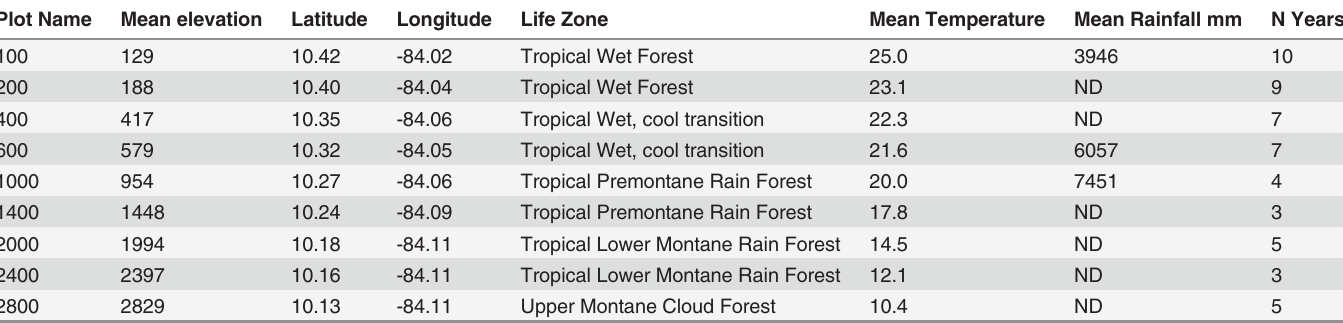
Plot names, mean elevation of the four corners from GPS data, latitude and longitude, life zone classi fi cation, mean temperature and rainfall, and number of years in which met data were collected. Life zone classi fi cations for all plots but the 2800 m plot follow Hartshorn and Peralta [45], the 2800 m plot follows Scatena et al. [18]. ND = no data